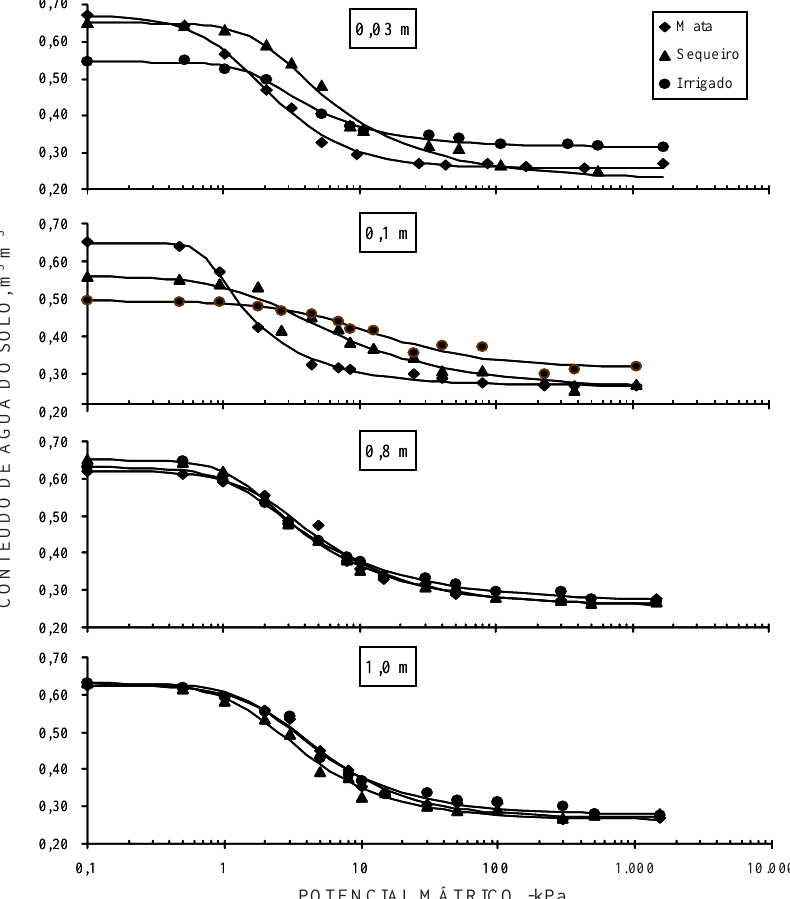
Figura 1. Curvas de retenção de água no solo para os manejos e profundidades, cada ponto experimental é oriundo de uma